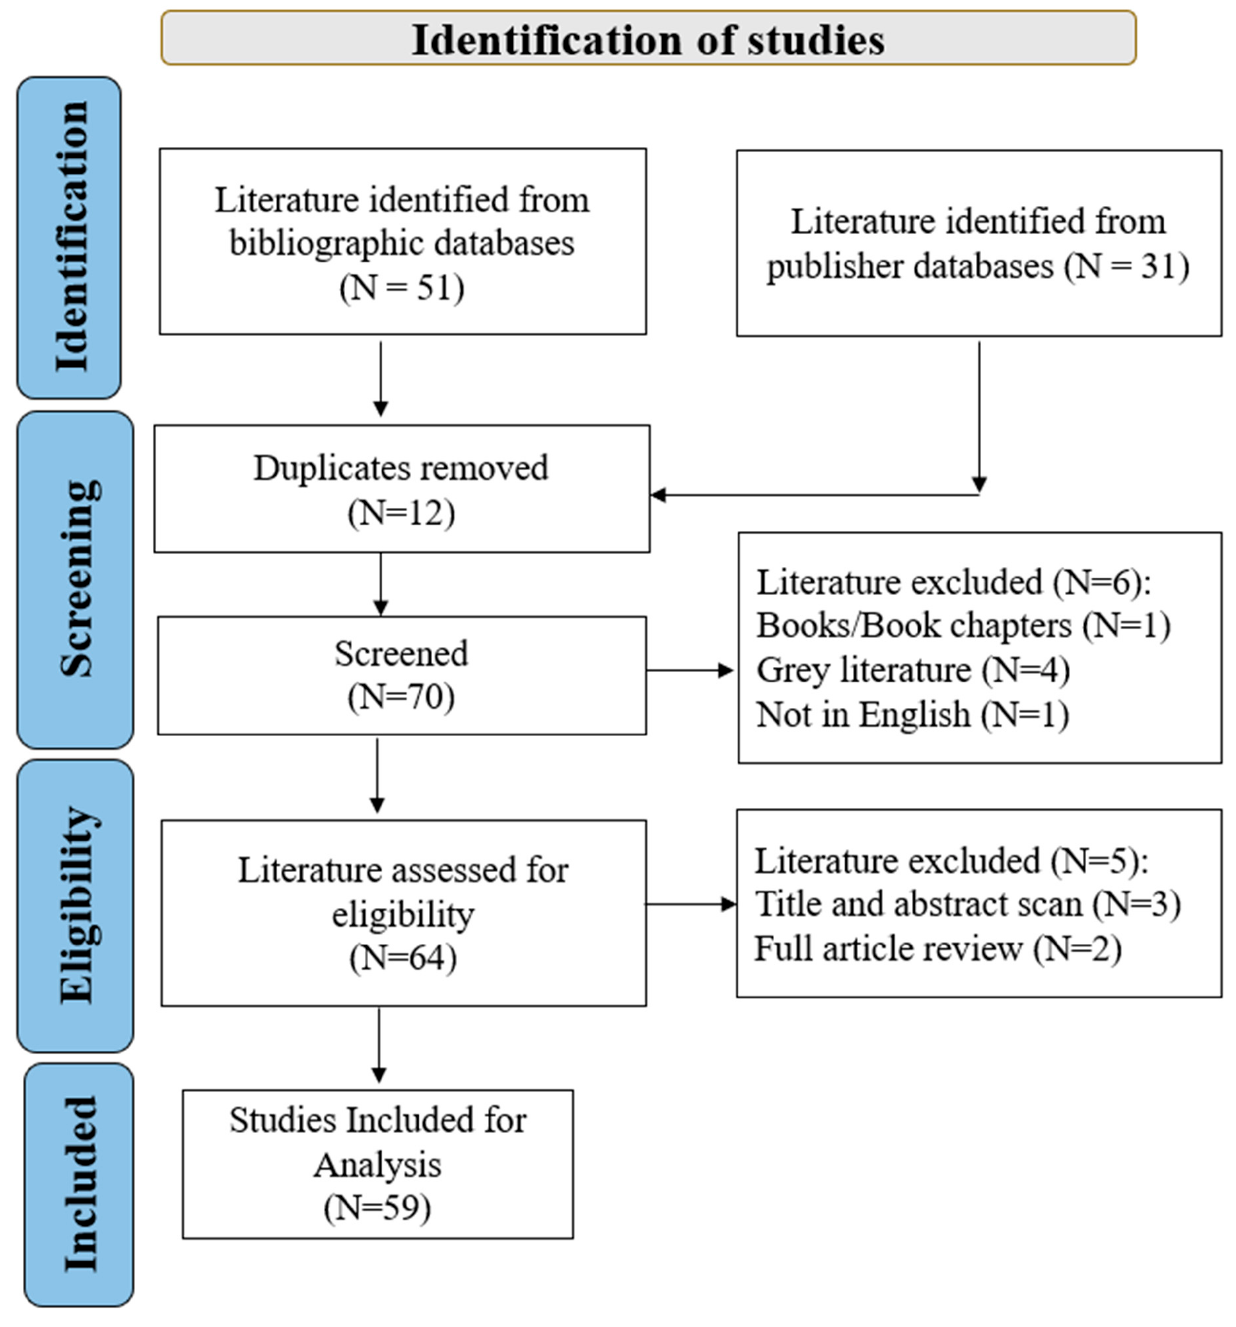
Figure 2. Literature selection criteria based on PRISMA .